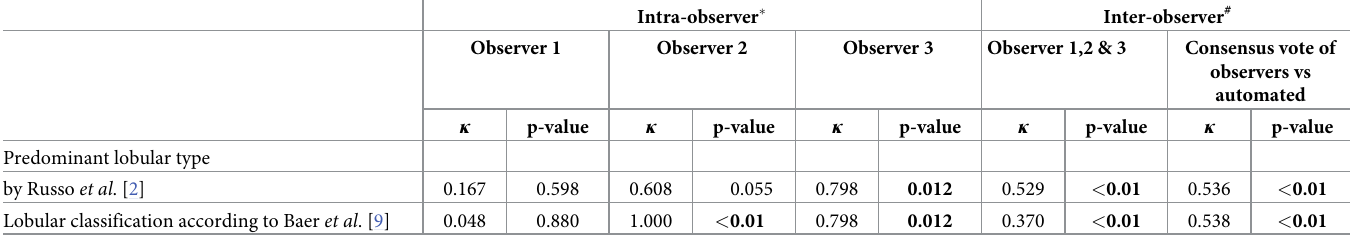
Table 3. Inter- and intra-observer Fleiss’ Kappa for qualitative terminal ductal lobular unit assessment among three observers using 40 and 10 cases, respectively.